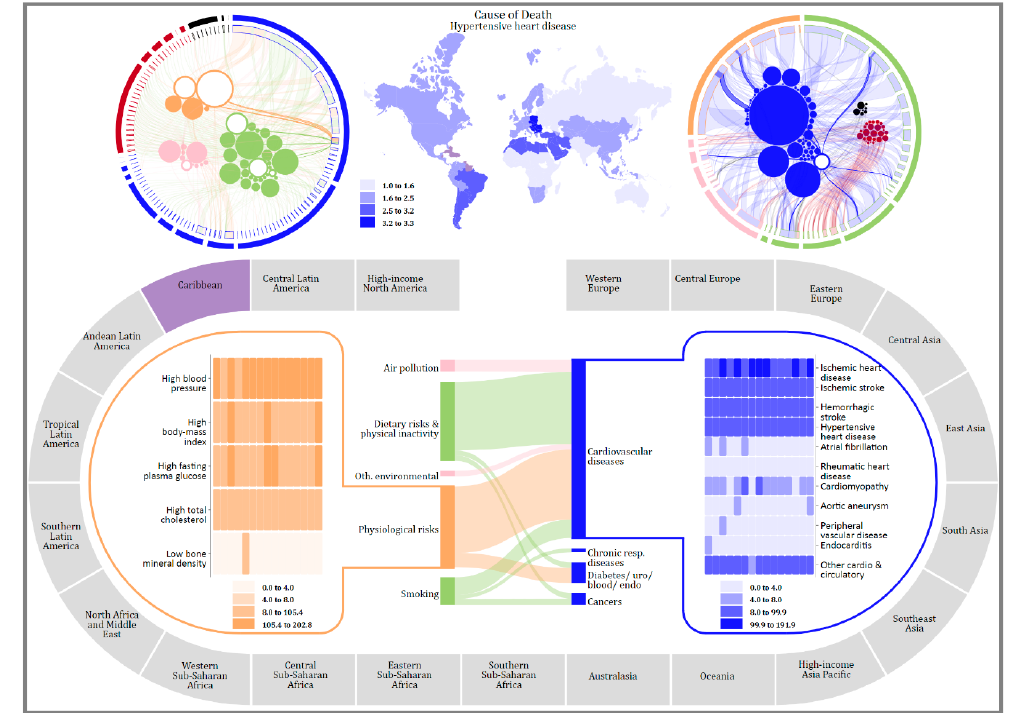
Figure 8. Geography visualization with hypertensive heart disease is selected in the top portion and the Caribbean is selected in the bottom portion.